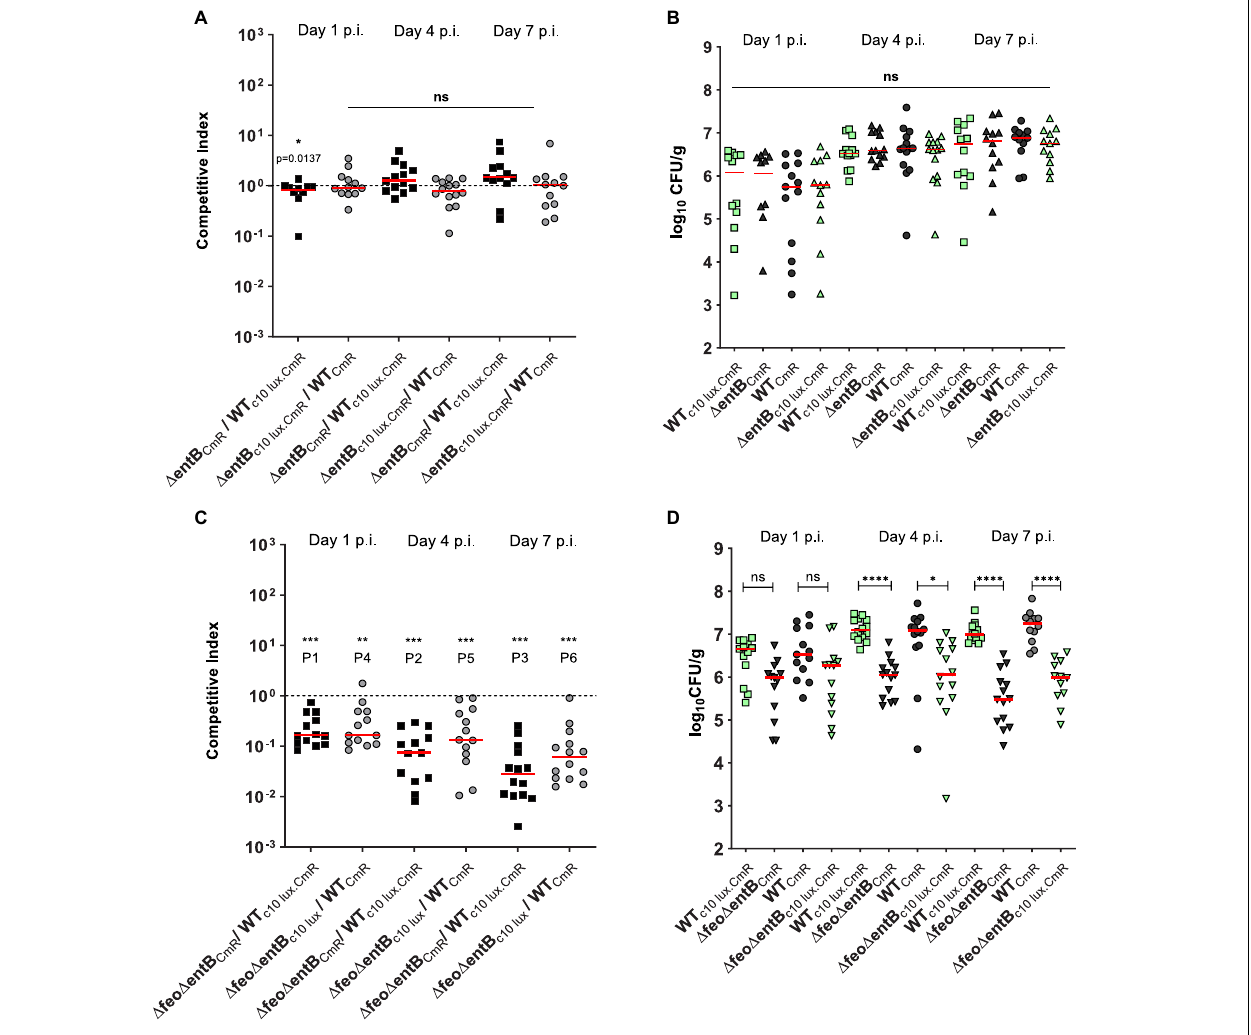
FIGURE 2 | (A,C) competitive index scores; mutant vswildtype in cecal tissue. A; ∆ entB vs wildtype strain, C; ∆ feo ∆ entB vs wildtype strain. Each symbol represents a CI value per bird (12–14 commercial broilers/group) calculated based upon bacteria recovered from cecal content as presented in figure B and D respectively. Median value of the data is given by the horizontal bar. Dotted horizontal line is the CI value of 1 which indicates that the mutant is equally competitive as the wildtype strain. ∗∗∗ P1, ∗∗∗ P2 = 0.0002, ∗∗∗ P3 = 0.0001, ∗∗ P4 = 0.0034, ∗∗∗ P5 = 0.0002, ∗∗∗ P6 = 0.0001. (B,D) Bacterial load in the cecal content. Each symbol represents a colony count of a particular bird, and each bird has a matching pair of wildtype and mutant colony counts due to the co-infection. The detection limit of Salmonella colonies in the brilliant green agar plate is around 100 CFU/g. Mean differences were calculated by appropriate statistical test. ns; no significance. ∗ p = 0.0142, ∗∗∗∗ p ≤